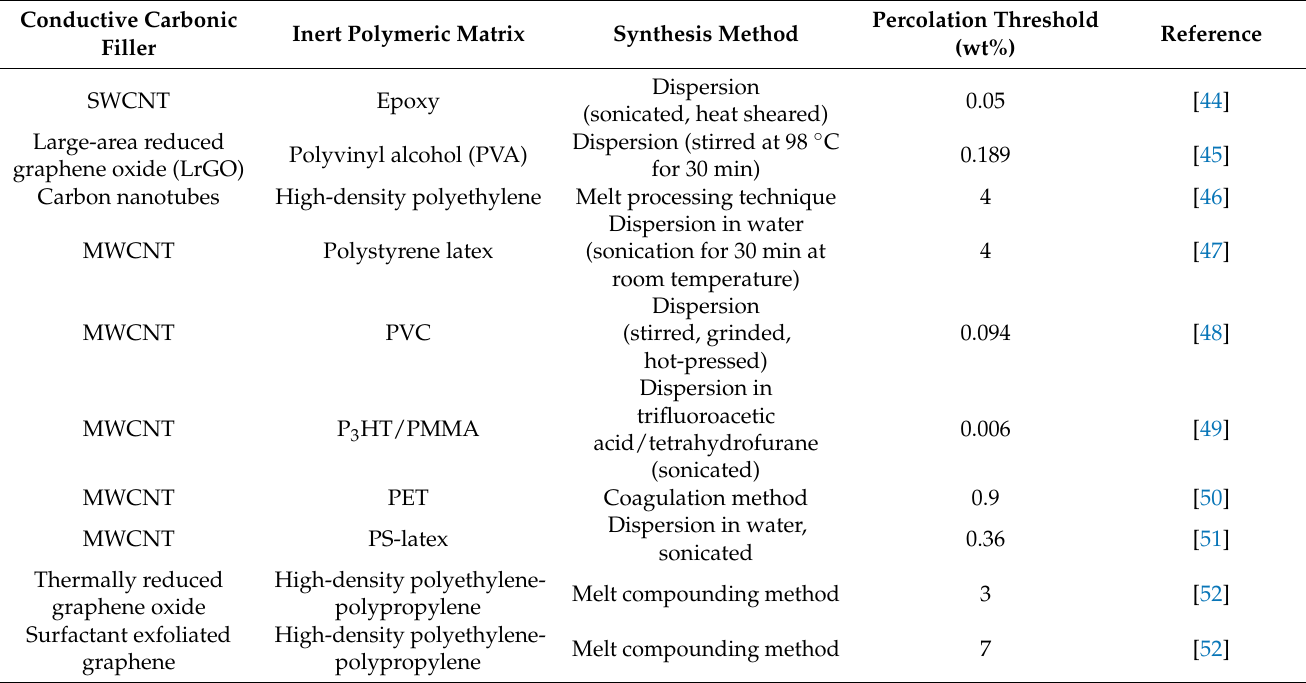
Table 1. Comparison of percolation threshold in different nanocomposites based on carbonic filler embedded in a polymeric matrix, as a function of the synthesis